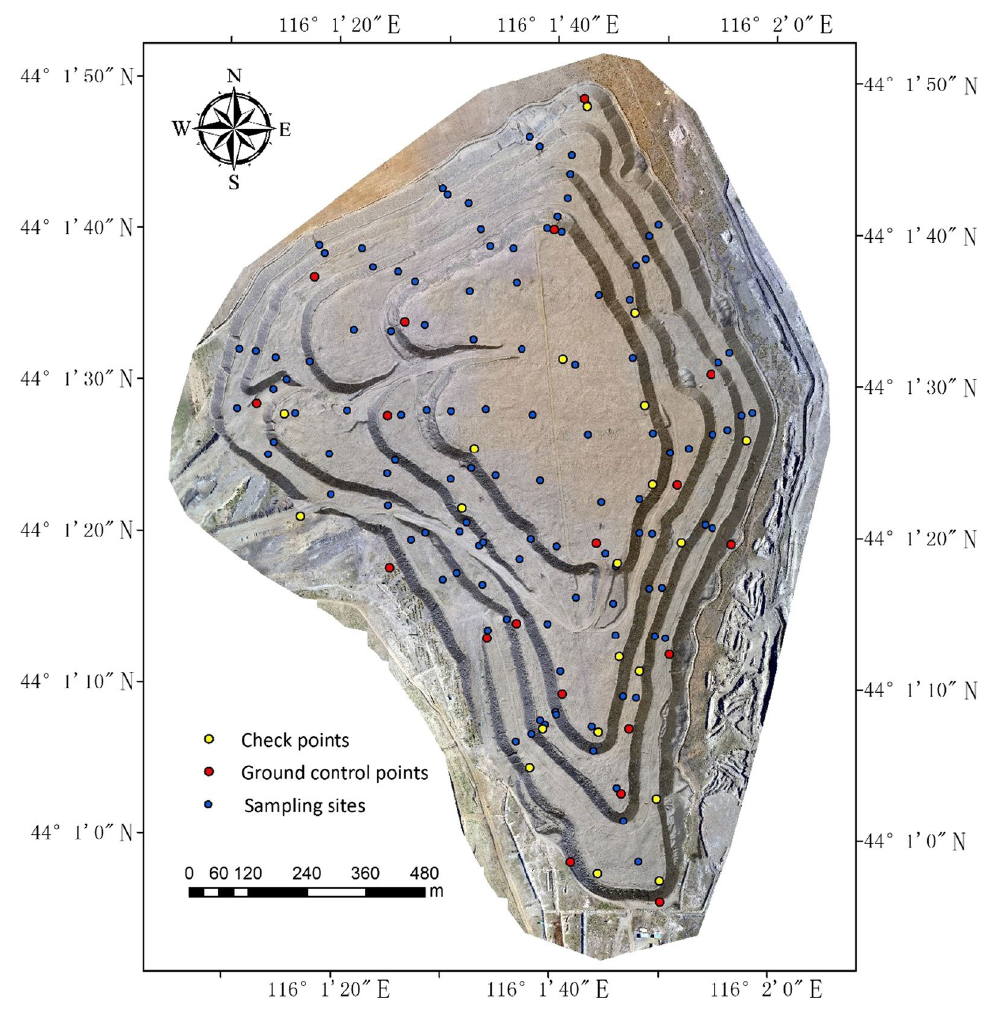
Fig. 5 Sketch map of ground control points, check points and sampling sites